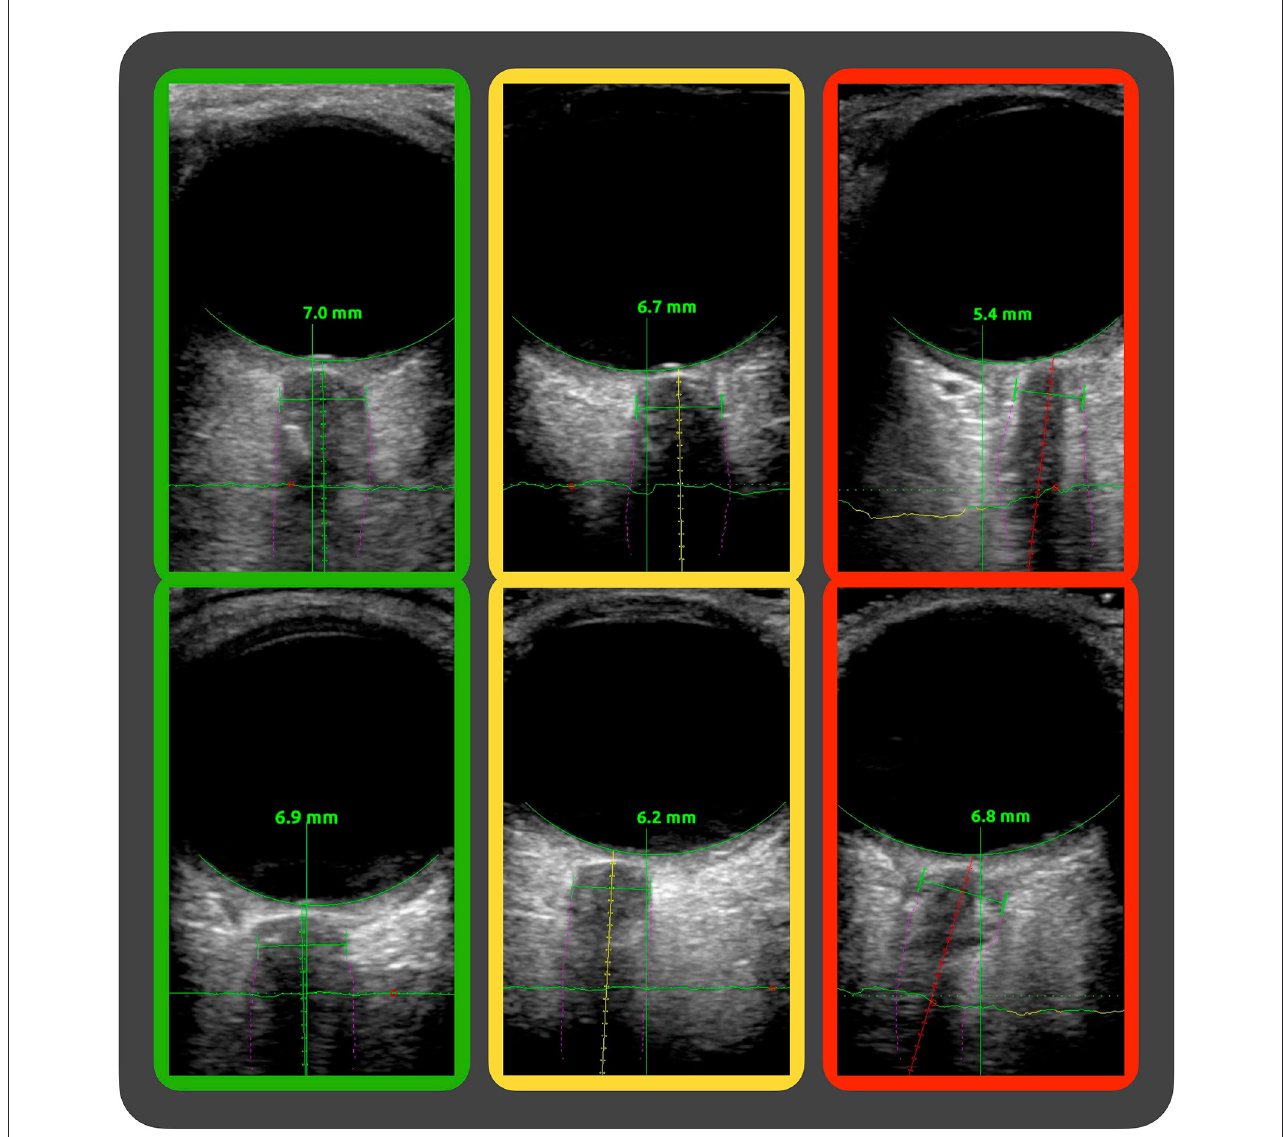
FIGURE6 Image examples of the software’s evaluation of axis alignment. Ultrasound images of the optic nerve sheath complex showing the software’s segmentation (purple fine lines) of the nerve sheath and guidance system with differing evaluations of the axis alignment along the optic nerve. In the green, yellow, and red framed image, the software evaluation of axis alignment is good, intermediate, and poor, respectively.